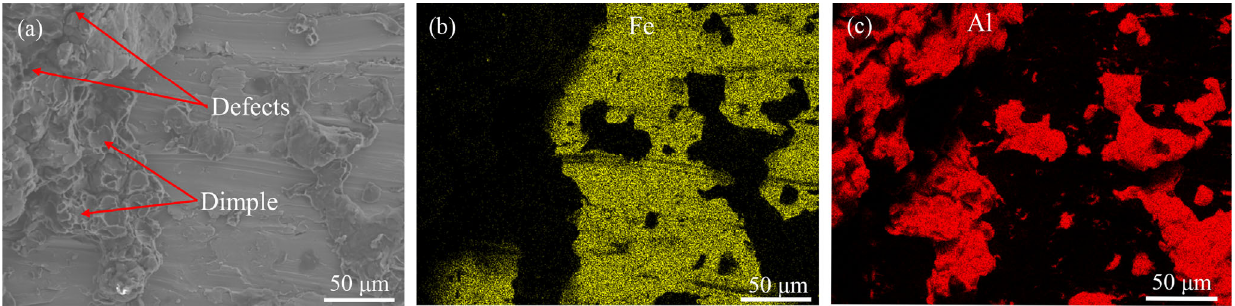
Figure 6. Fracture morphology of cold-sprayed Al coating: ( a ) SEM and ( b , c ) EDS (yellow, Fe; red, Al).